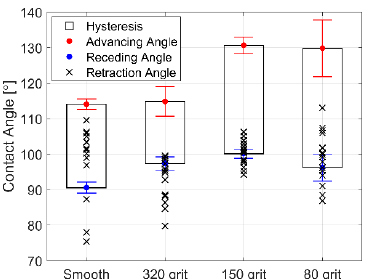
Figure 6. R a Contact angle (CA) hysteresis, as well as advancing and receding CAs for deionized water on smooth and roughened surfaces coated with FluoroSyl. The final CAs of spread droplets after vibration (retraction angle) are plotted as an “x”.